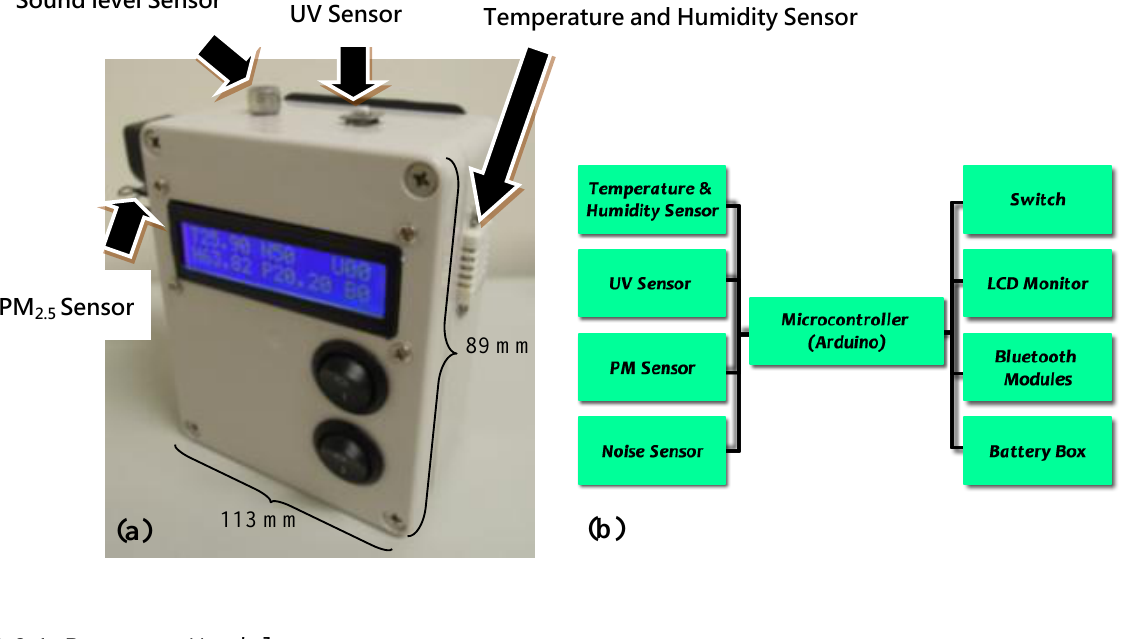
Figure 2. ( a ) Exterior view of IEMD; ( b ) interior view of